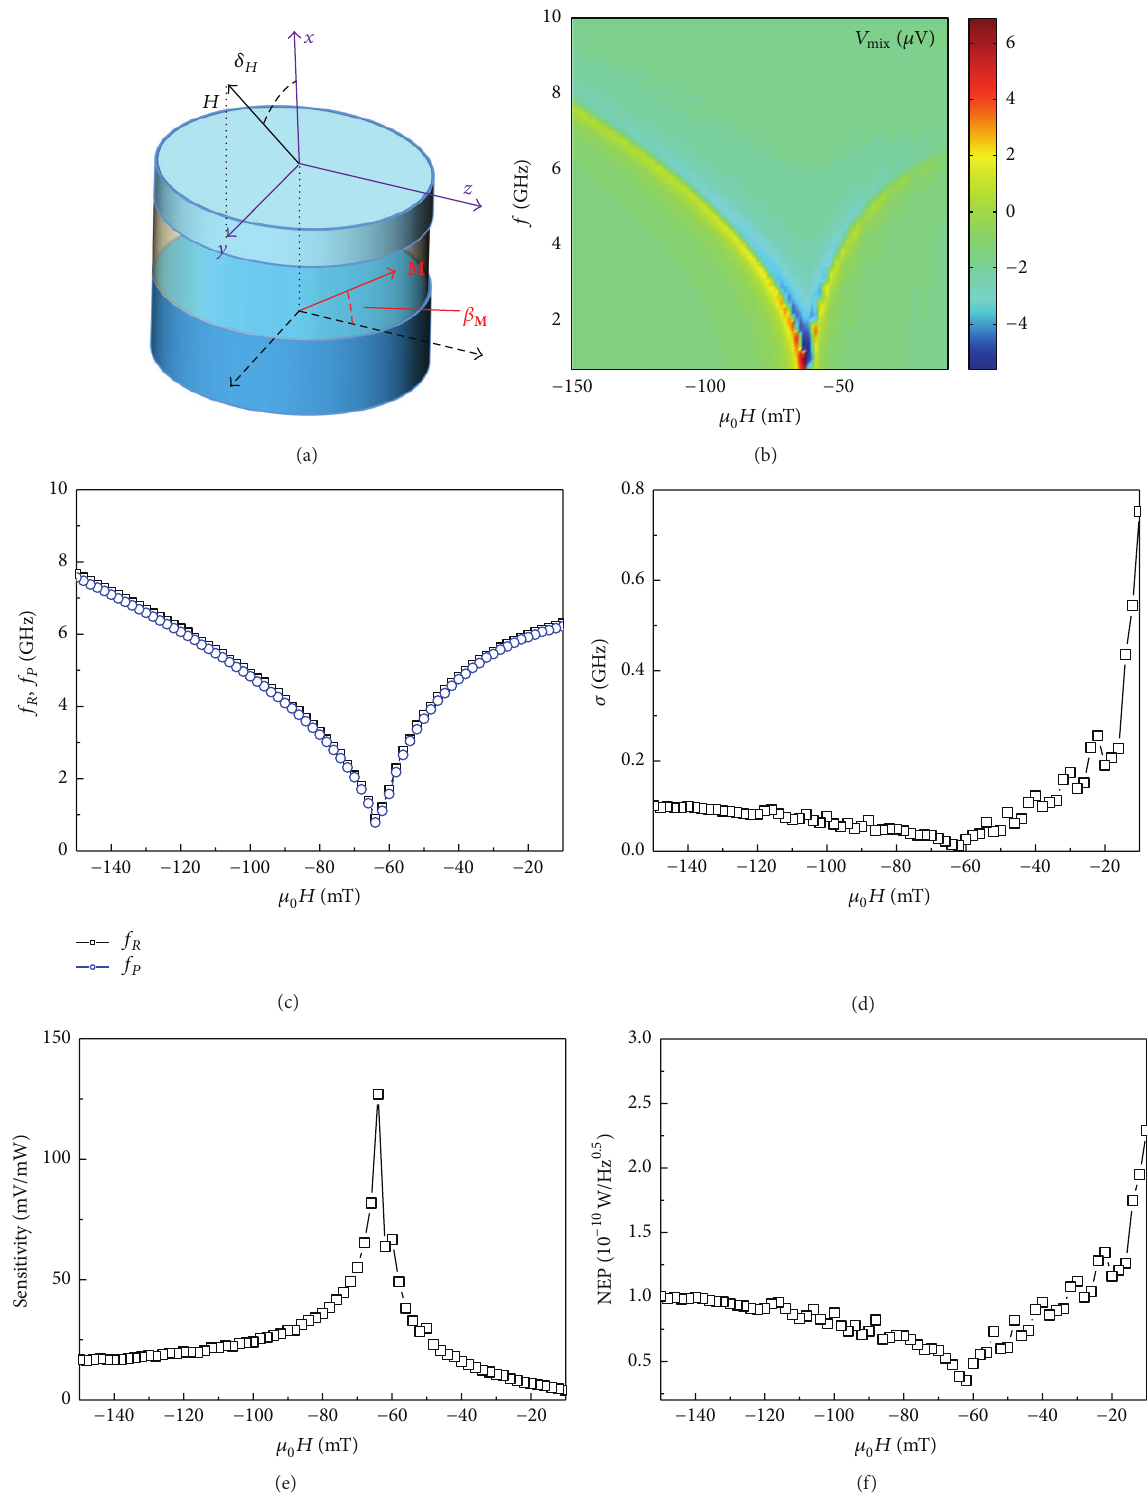
Figure 2: (a) Schematic of alignment between 𝐻 and M , (b) 𝑉 mix - 𝑓 spectra, (c) FMR frequency ( 𝑓 𝑅 ) and peak frequency ( 𝑓 𝑃 ), (d) line-width, (e) sensitivity, and (f) NEP when the magnitude of magnetic field is changed from − 10mT to −